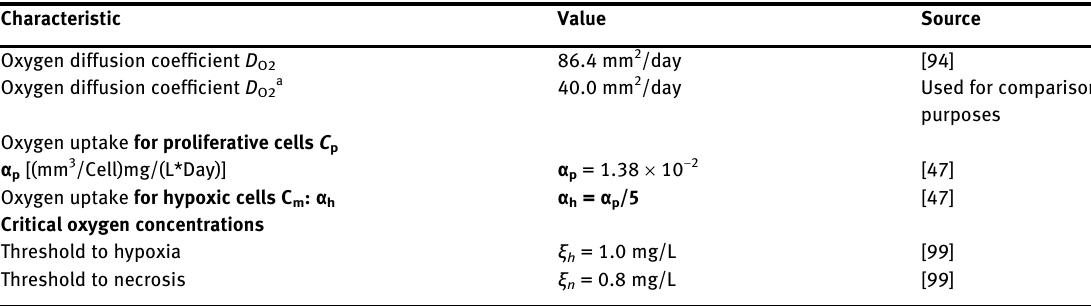
Table  : Oxygen transport and